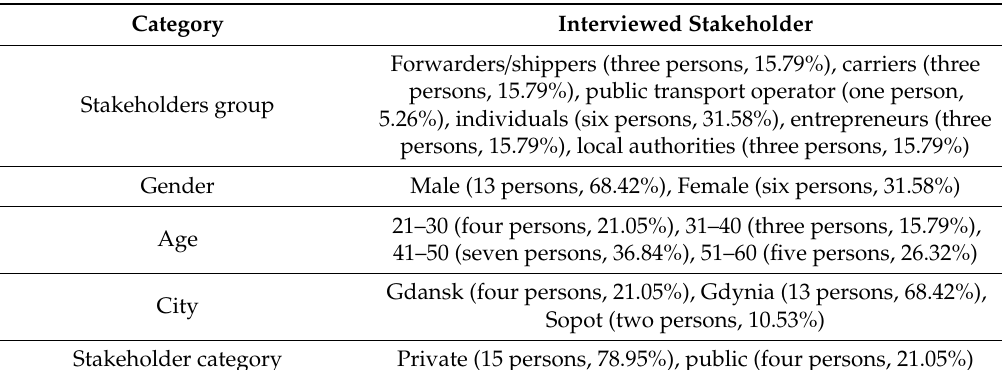
Table 4. Interviewees